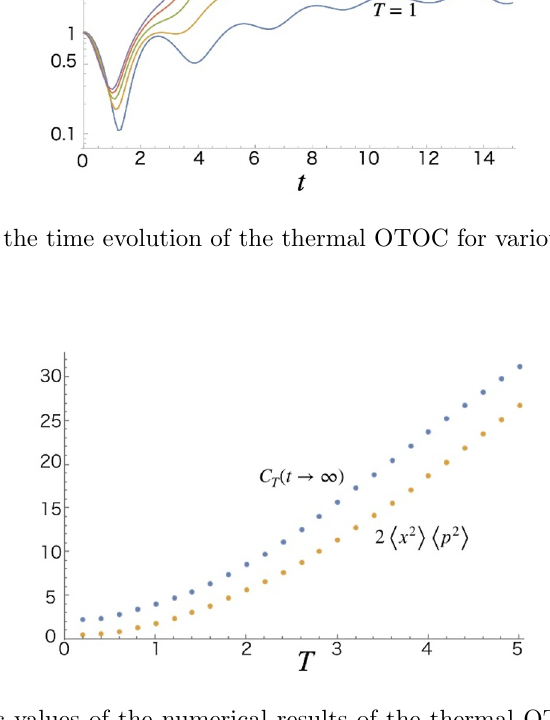
Figure 6 . Asymptotic values of the numerical results of the thermal OTOC and the property of the OTOC in a quantum chaotic system